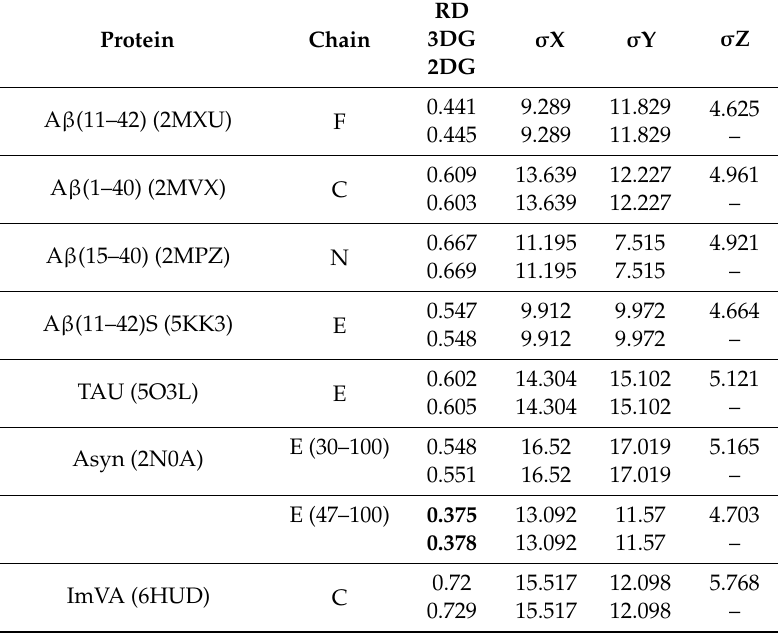
Table 5. Status of single, centrally located protofibril chains treated as an independent, individual structural unit (Gaussian distributions were determined for the mentioned chains). The RD and σ parameter values are given for 3D and 2D Gaussian distributions, respectively. Protofibril orientation as in Table